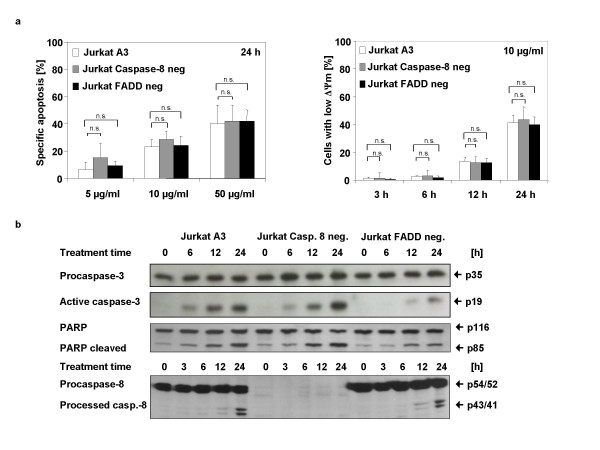
(a) Expression of caspase-8 and FADD are not essential for Ukrain-induced apoptosis. Jurkat A3 control cells as well as FADD-deficient and caspase-8-deficient Jurkat cells were treated for 24 h with medium or 5, 10 and 50 μg/ml Ukrain. Apoptosis was then determined by flow cytometry using light scatter characteristics (left panel). Alternatively, A3, FADD-deficient and caspase-8-deficient Jurkat cells were treated for 3, 6, 12 and 24 h with medium or 10 μg/ml Ukrain. Apoptosis induction was then quantified by determination of the mitochondrial membrane potential (Δψm) (right panel). Data show induction of specific apoptosis (means ± SD; n ≥ 3). One-way ANOVA was performed using GraphPad InStat version 3.00 for Windows 95, GraphPad Software, San Diego California USA, . (b) Expression of caspase-8 and FADD are not essential for Ukrain-induced caspase-activation. Jurkat A3 as well as FADD-deficient and caspase-8-deficient Jurkat cells were treated for 6, 12 and 24 h with medium or 10 μg/ml Ukrain. Caspase activation was then determined by Western blot analysis of cytosolic extracts with specific antibodies against caspase-3, cleaved caspase-3, PARP and cleaved PARP, respectively. In addition, cells were treated for 3, 6, 12 and 24 h with medium or 10 μg/ml Ukrain and Western blot analysis with specific antibodies against caspase-8 was performed. Data from one representative experiment are shown.